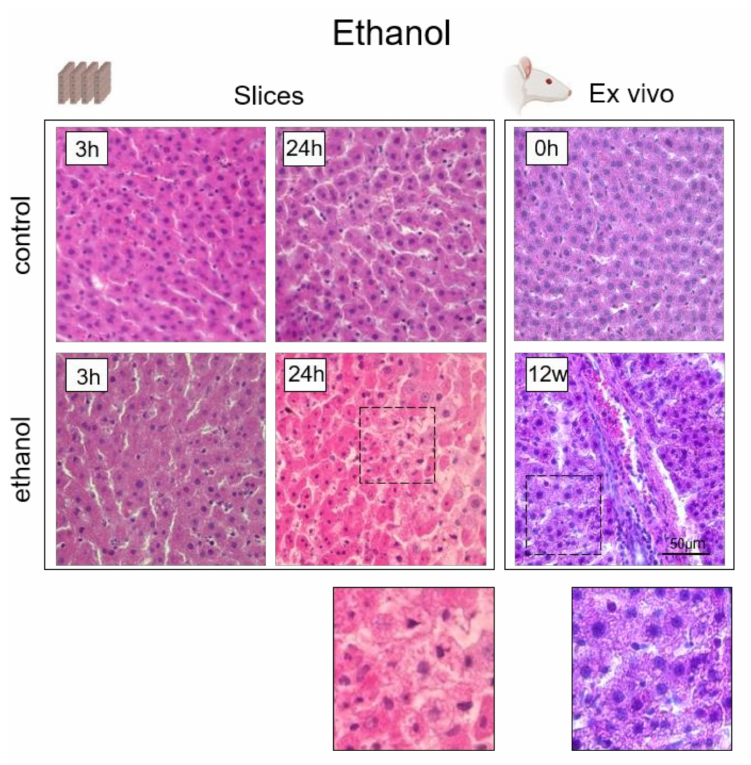
Figure 8. Histological images of liver tissue in its normal state and when exposed to ethanol. Hematoxylin and eosin staining, × 400; scale bar: 50 µ